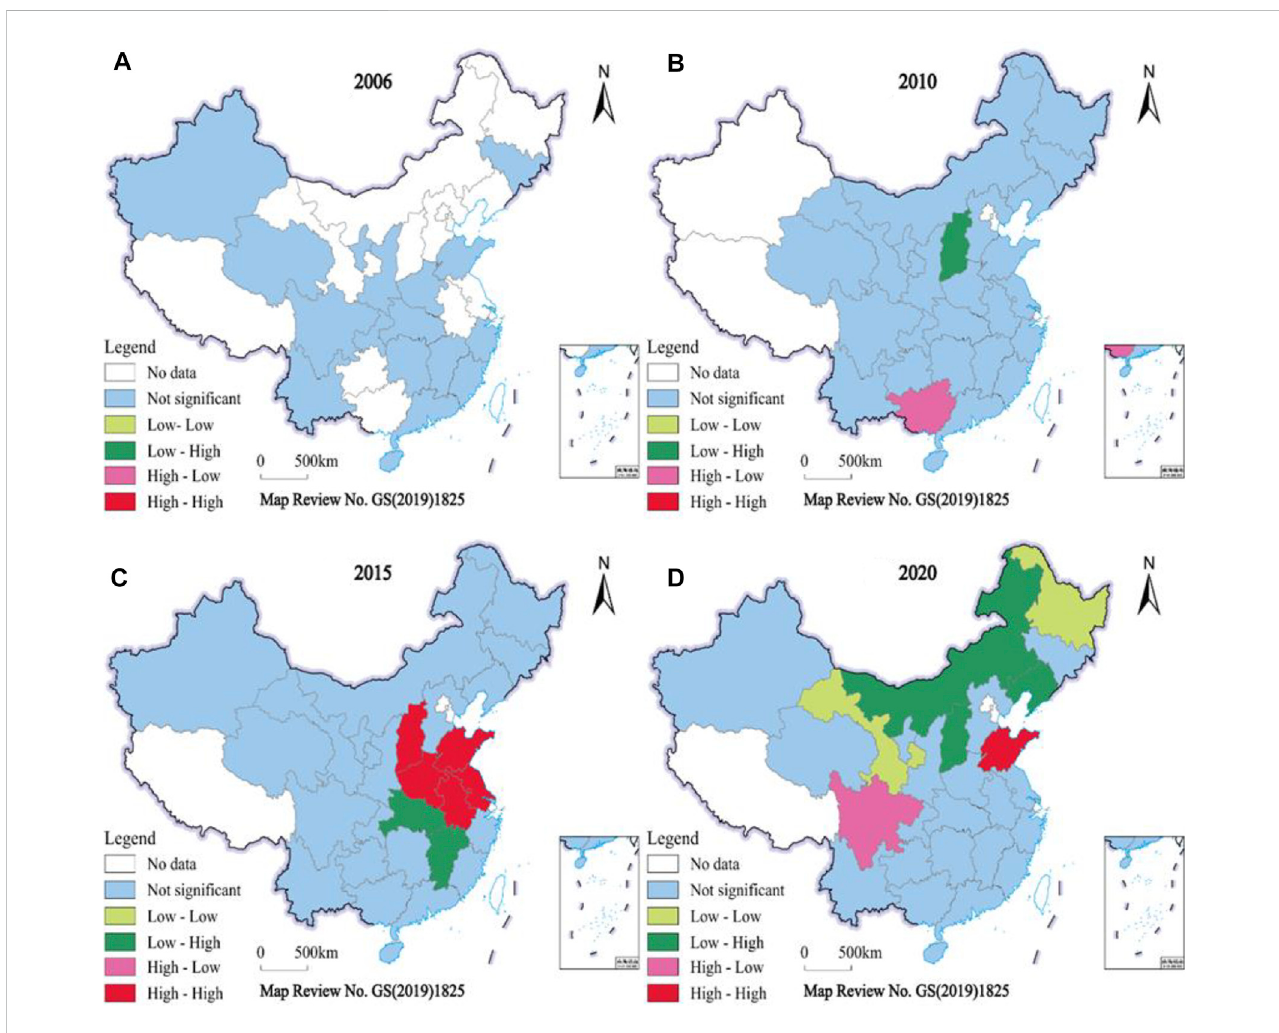
FIGURE 3 LISA agglomeration map of county solid waste harmless disposal capacity in China (from (A – D)